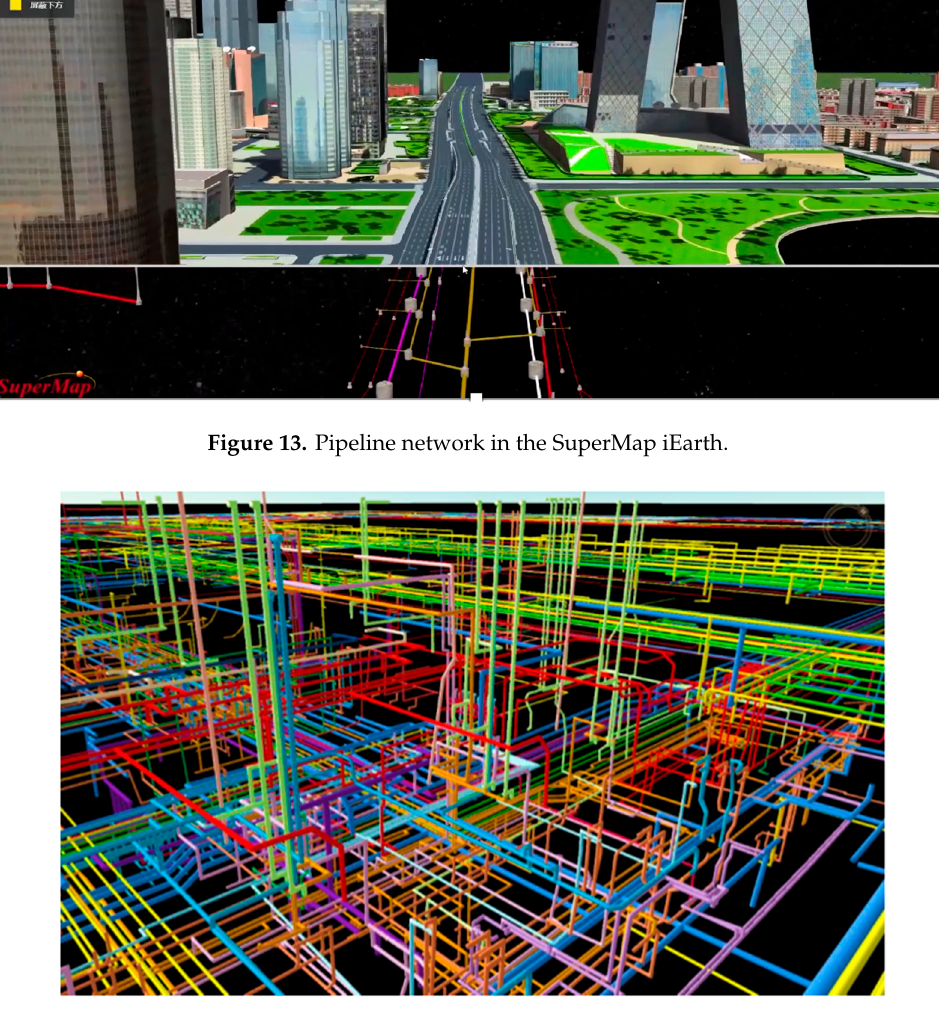
Figure 14. Pipeline network in the experiment.